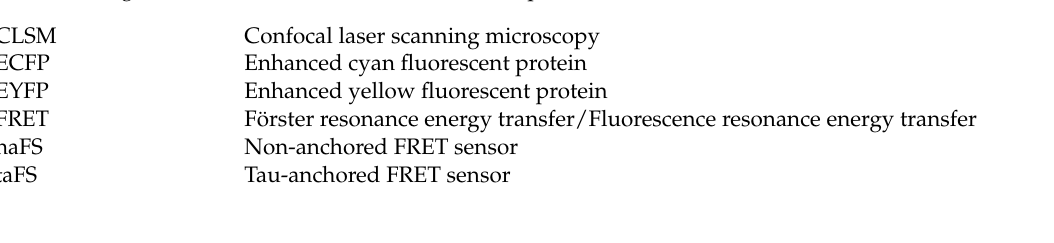
Figure S1: FRET decay in soma and protrusions. Mean FRET intensity in the indicated regions of interest (ROIs) within SK-N-AS cells overexpressing taFS-VEID ( A , B ) or naFS-VEID ( C , D ) presented in Figure 2A (see main